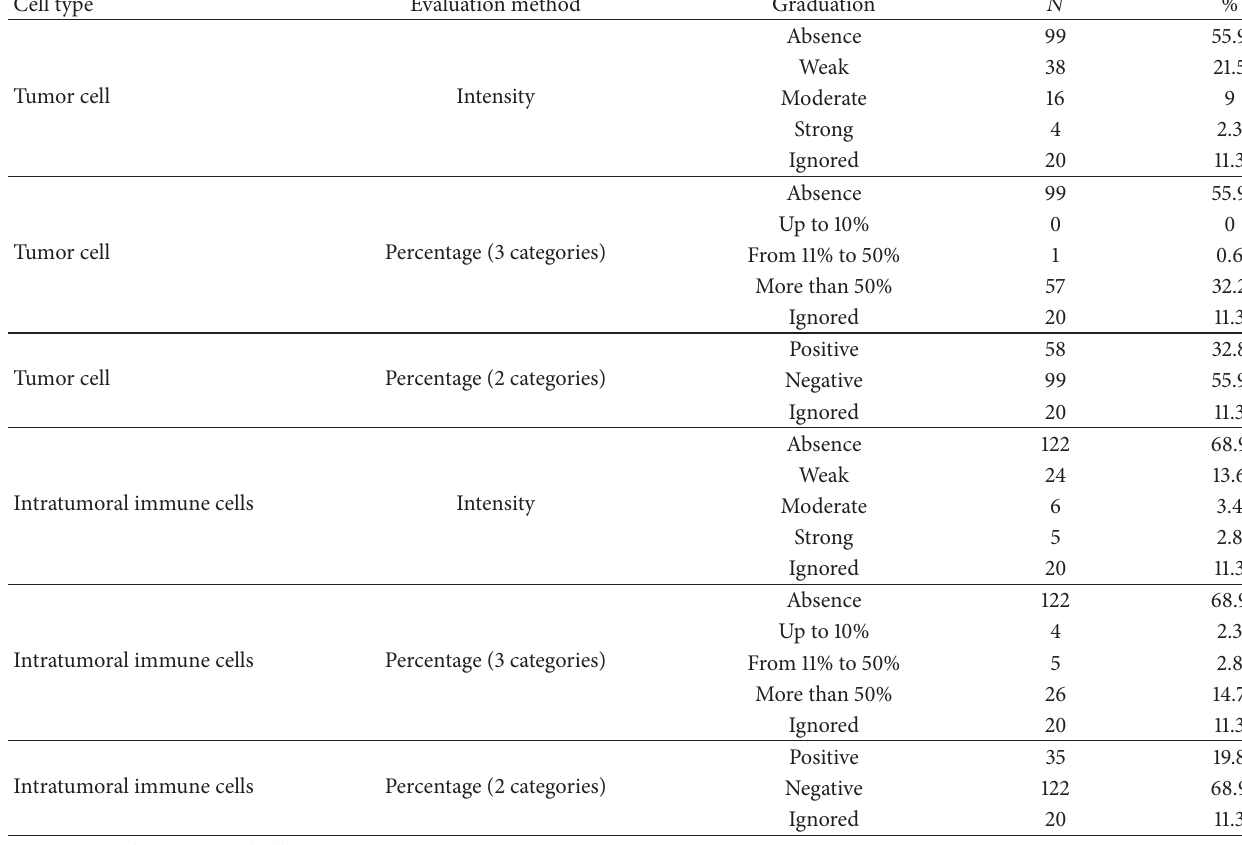
Table 4: PD-L1 expression in TMA slides (collective analysis).